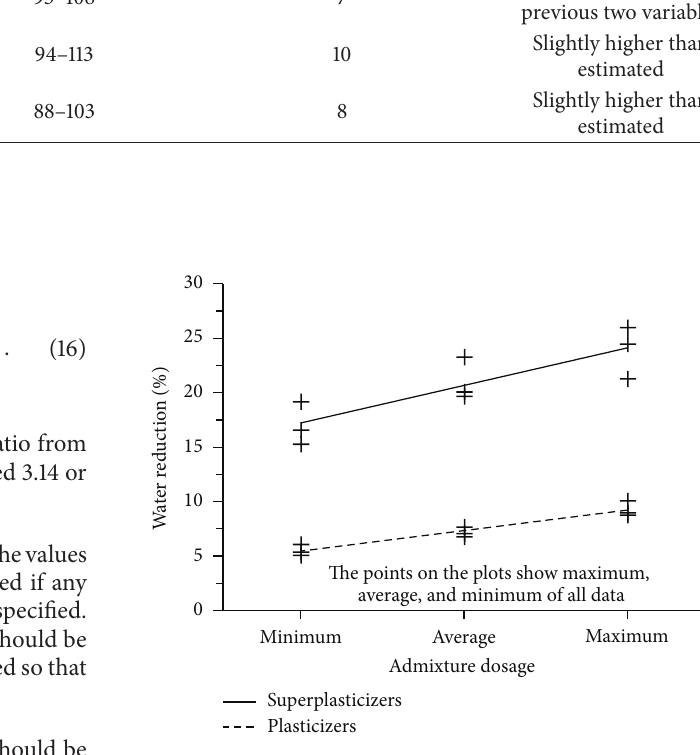
Figure 6: Water reduction when admixtures are